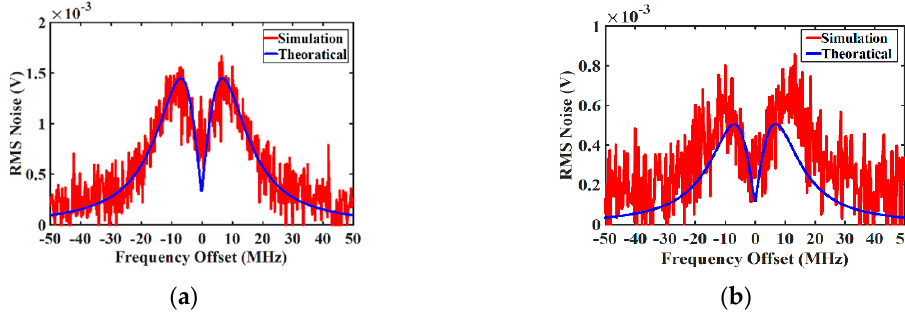
Figure 2. ( a ) Theoretical and simulated stimulated Brillouin scattering (SBS)-induced noise in gain-based Brillouin optical time-domain analyzers (G-BOTDA) and ( b ) loss-based Brillouin optical time-domain analyzers (L-BOTDA). In gain/loss-based BOTDA, the total theoretical noise (blue solid curve) consists of phase-to-intensity (P-I) noise and spontaneous Brillouin scattering (SpBS)-probe beating noise.